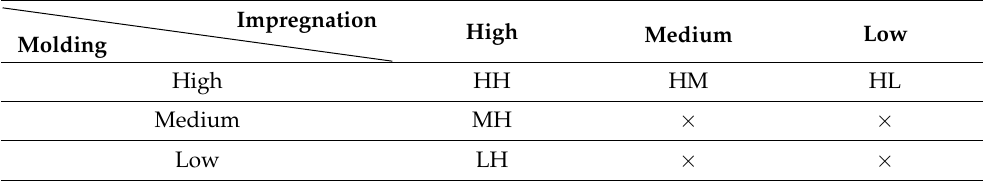
Table 1. Different combination of molding and impregnation pressures for fabricating composite bipolar plates (BPs). Impregnation High Molding